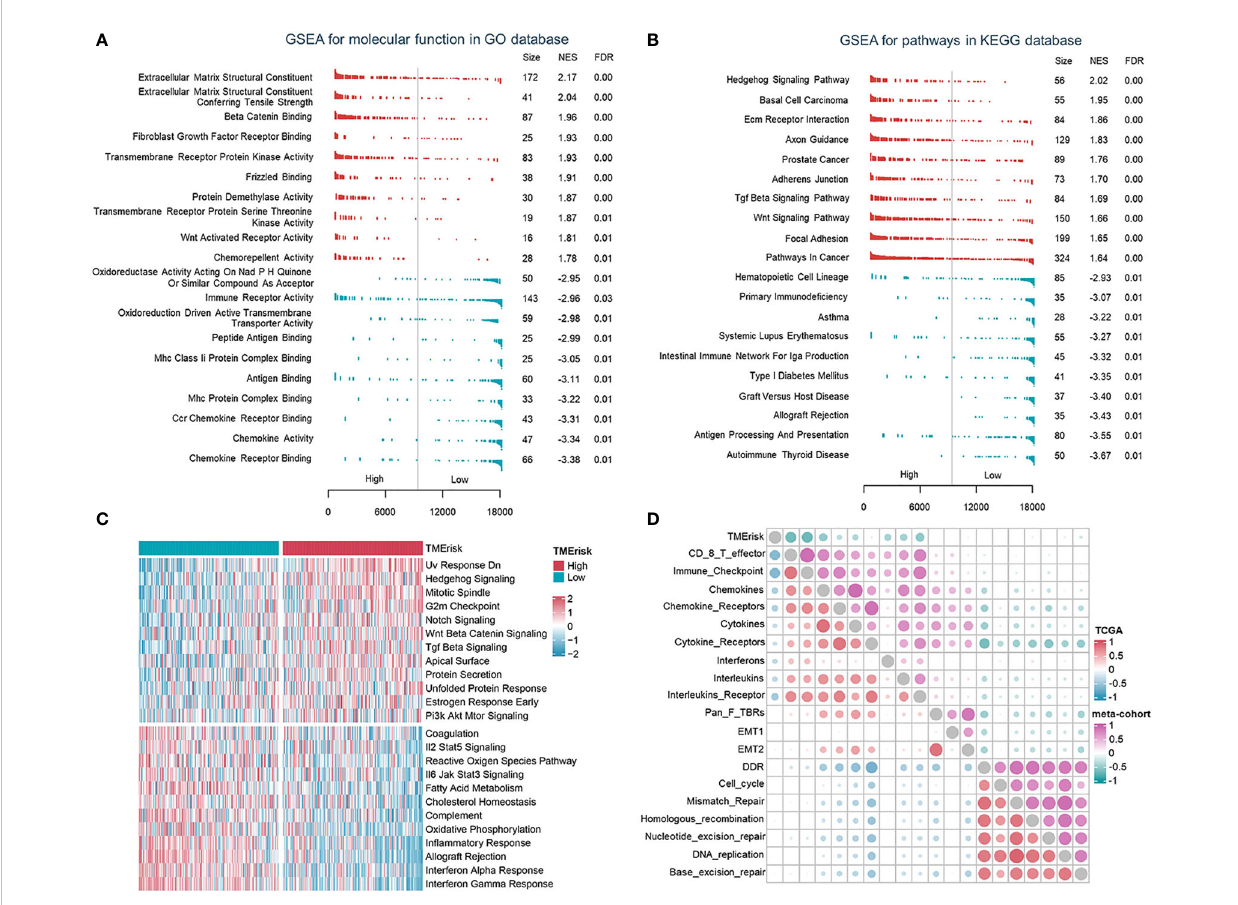
FIGURE 4 The TMErisk score was associated with immune-related pathways in HGSOC. (A, B) Analysis of GO molecular function (A) and KEGG pathway gene sets (B) in the low- and high-TMErisk groups. (C) Analysis of hallmark gene sets in the low- and high-TMErisk groups. (D) The correlations between TMErisk score and immune-related